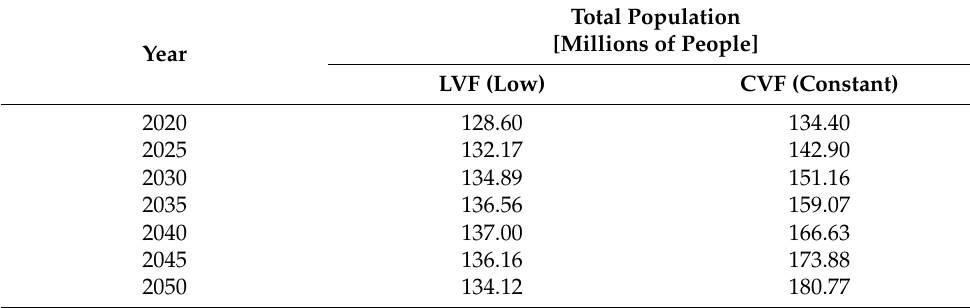
Table 4. Population perspective to the year 2050. Source: [29].